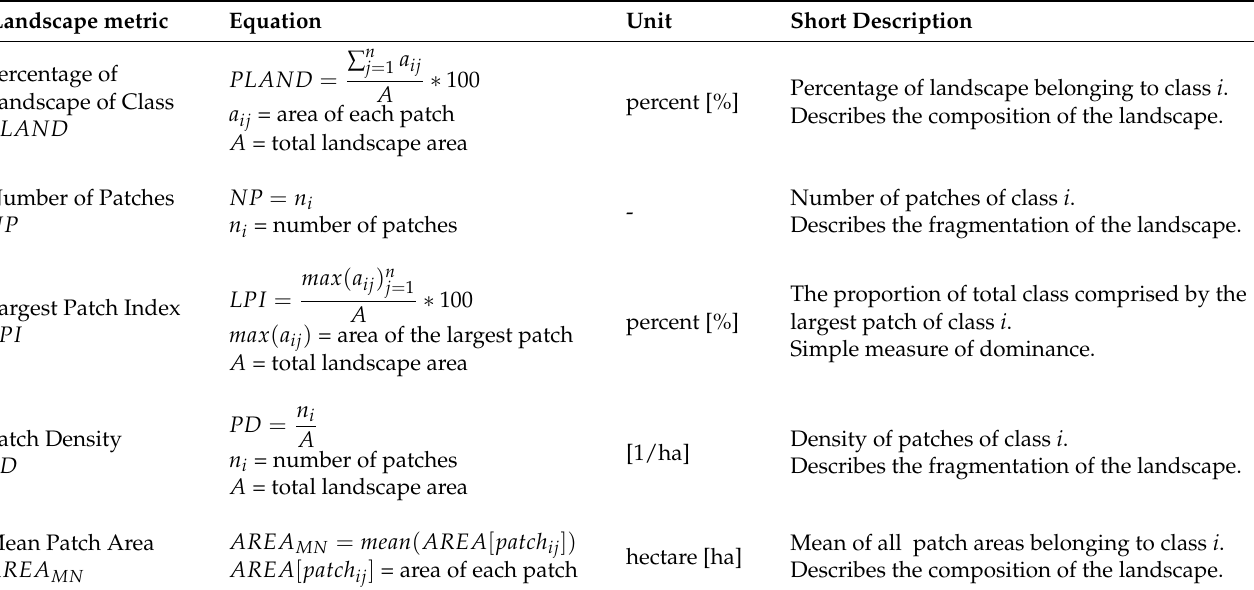
Table 1. Used landscape metrics in this study (adapted from [80,81]).